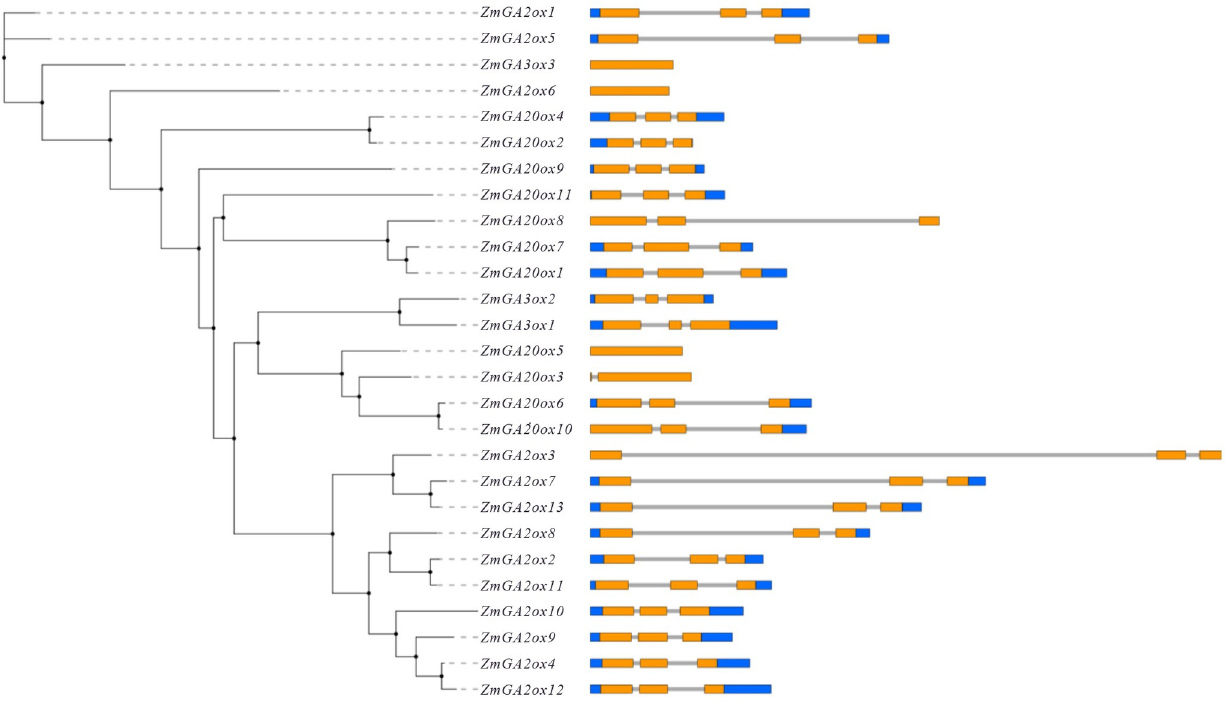
Fig 1. Gene structure of gibberellin-dioxygenases genes in maize. For gene structure analysis, genomic and CDS sequences were used for drawing gene structure schematic diagrams with the Gene Structure Display Server from the Center for Bioinformatics at Peking University (http://gsds.cbi.pku.edu.cn/